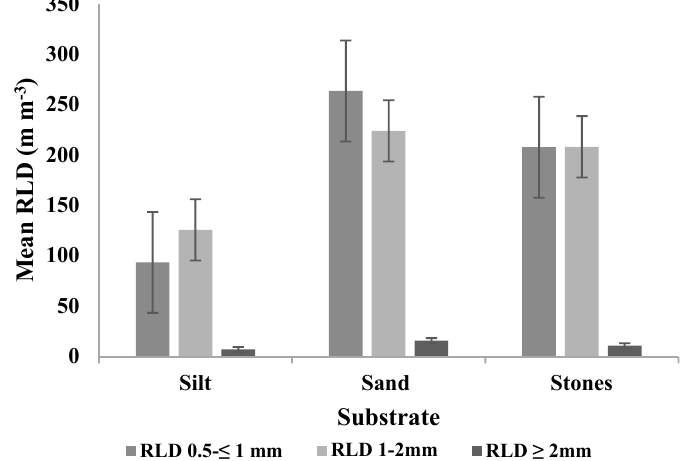
Figure 2. Variation in root length density (RLD) with depth class and substrate. Error bars are 1 SE.